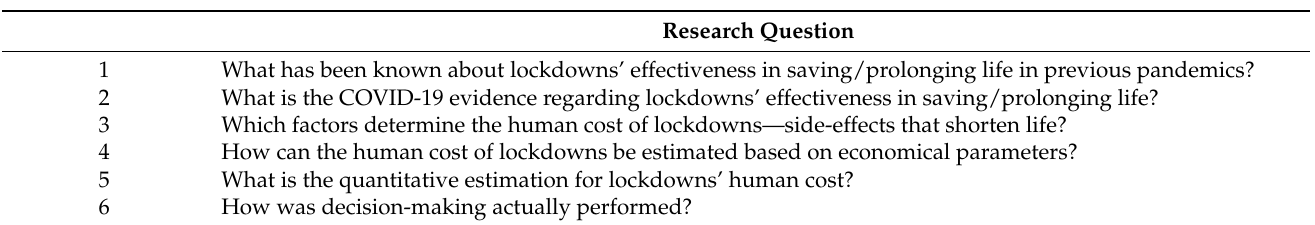
Table 1. Research questions of the present study.